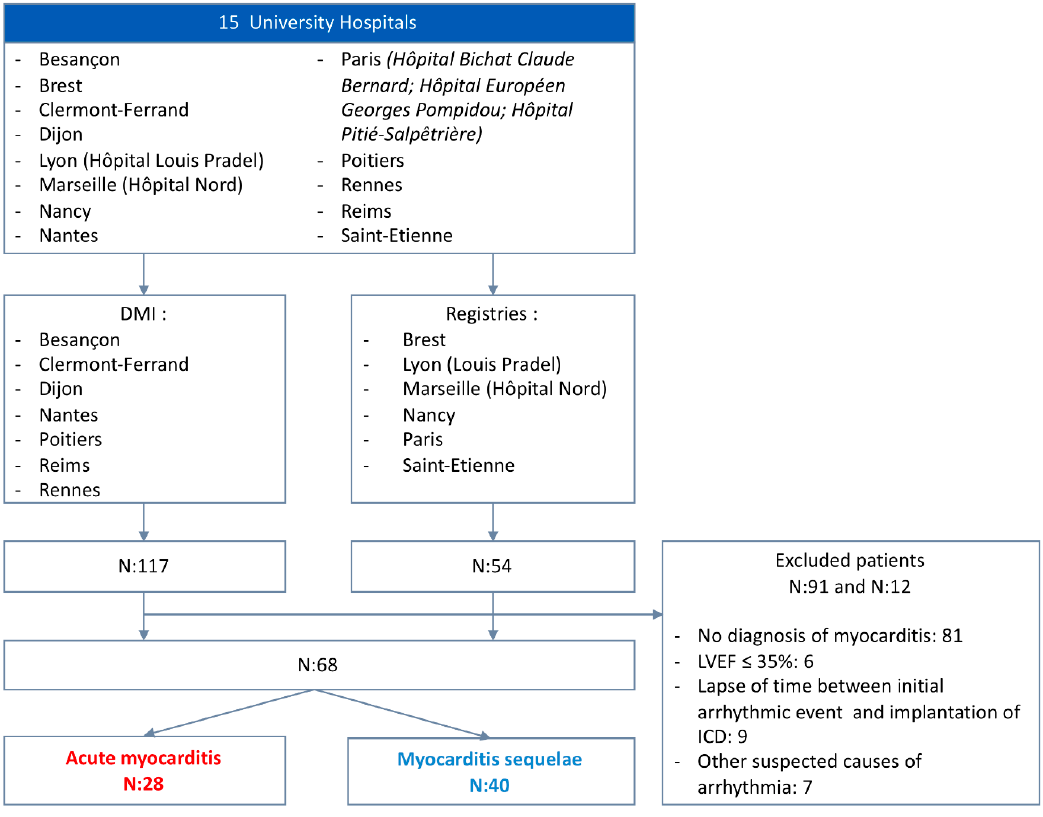
Figure 1. Study population.